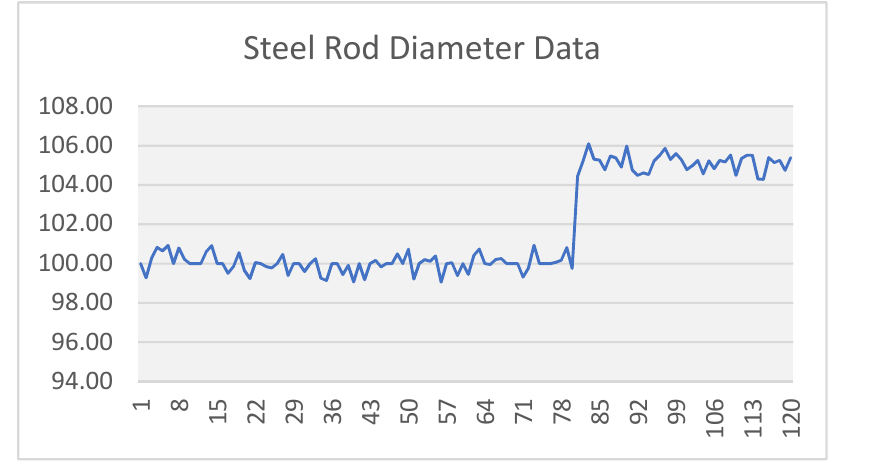
Table 1. Regime shift points. Figure 5. Steel rod diameter data. Figure 5. Steel rod diameter data.